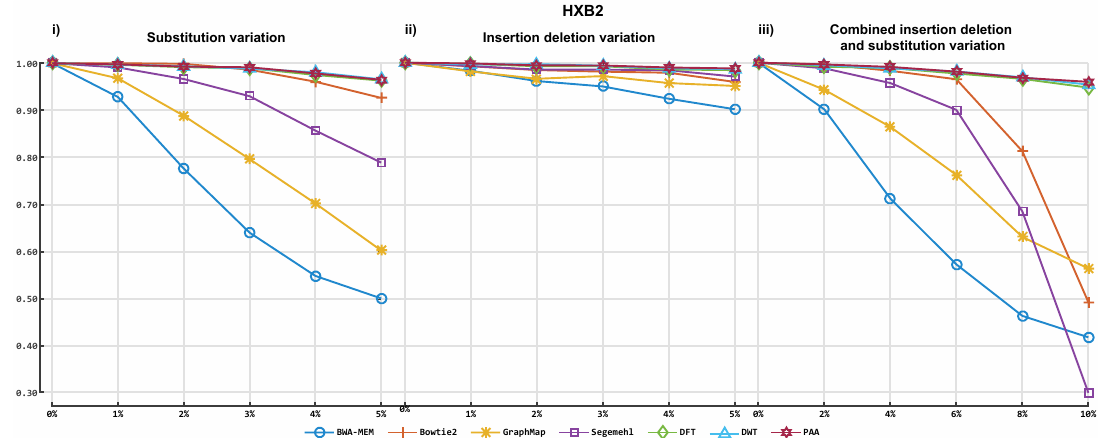
Figure 7. Accuracy of our prototype reference alignment implementation and four established tools on HIV-1 HXB2 simulated datasets. This Figure illustrates the F -measures obtained on the 16 different HIV datasets. Plot 6-( i ) depicts the F -measures obtained for each aligner on the simulations with 0% to 5% of substitution variation rate. Plot 6-( ii ) illustrates the F -measures obtained for each aligner on the simulations with 0% to 5% uniform insertion/deletion variation, and plot 6-( iii ) illustrates the F -measures obtained for each tool on simulations of uniform 0% to 10% insertion/deletion and substitution variation. DFT: discrete Fourier transform; DWT: discrete wavelet transform; PAA: piece-wise aggregate approximation.